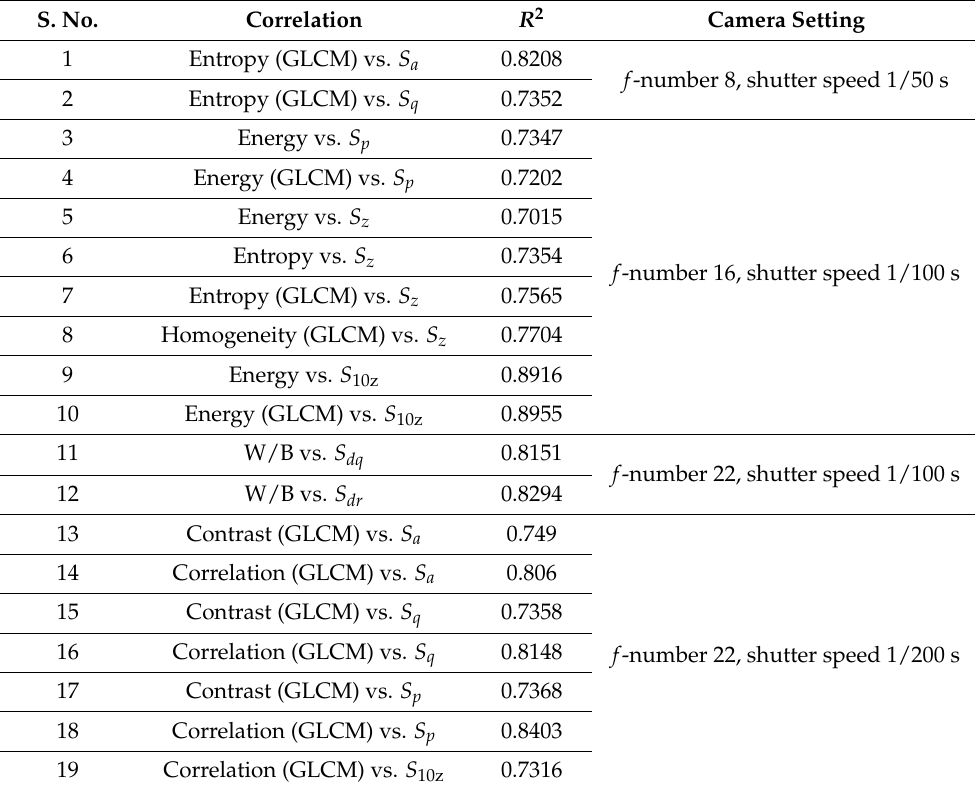
Table 6. Tabulation of R 2 ≥ 0.7 for an illumination angle of 45 ◦ for experimental setup 2. S. No. Correlation R 2 Camera